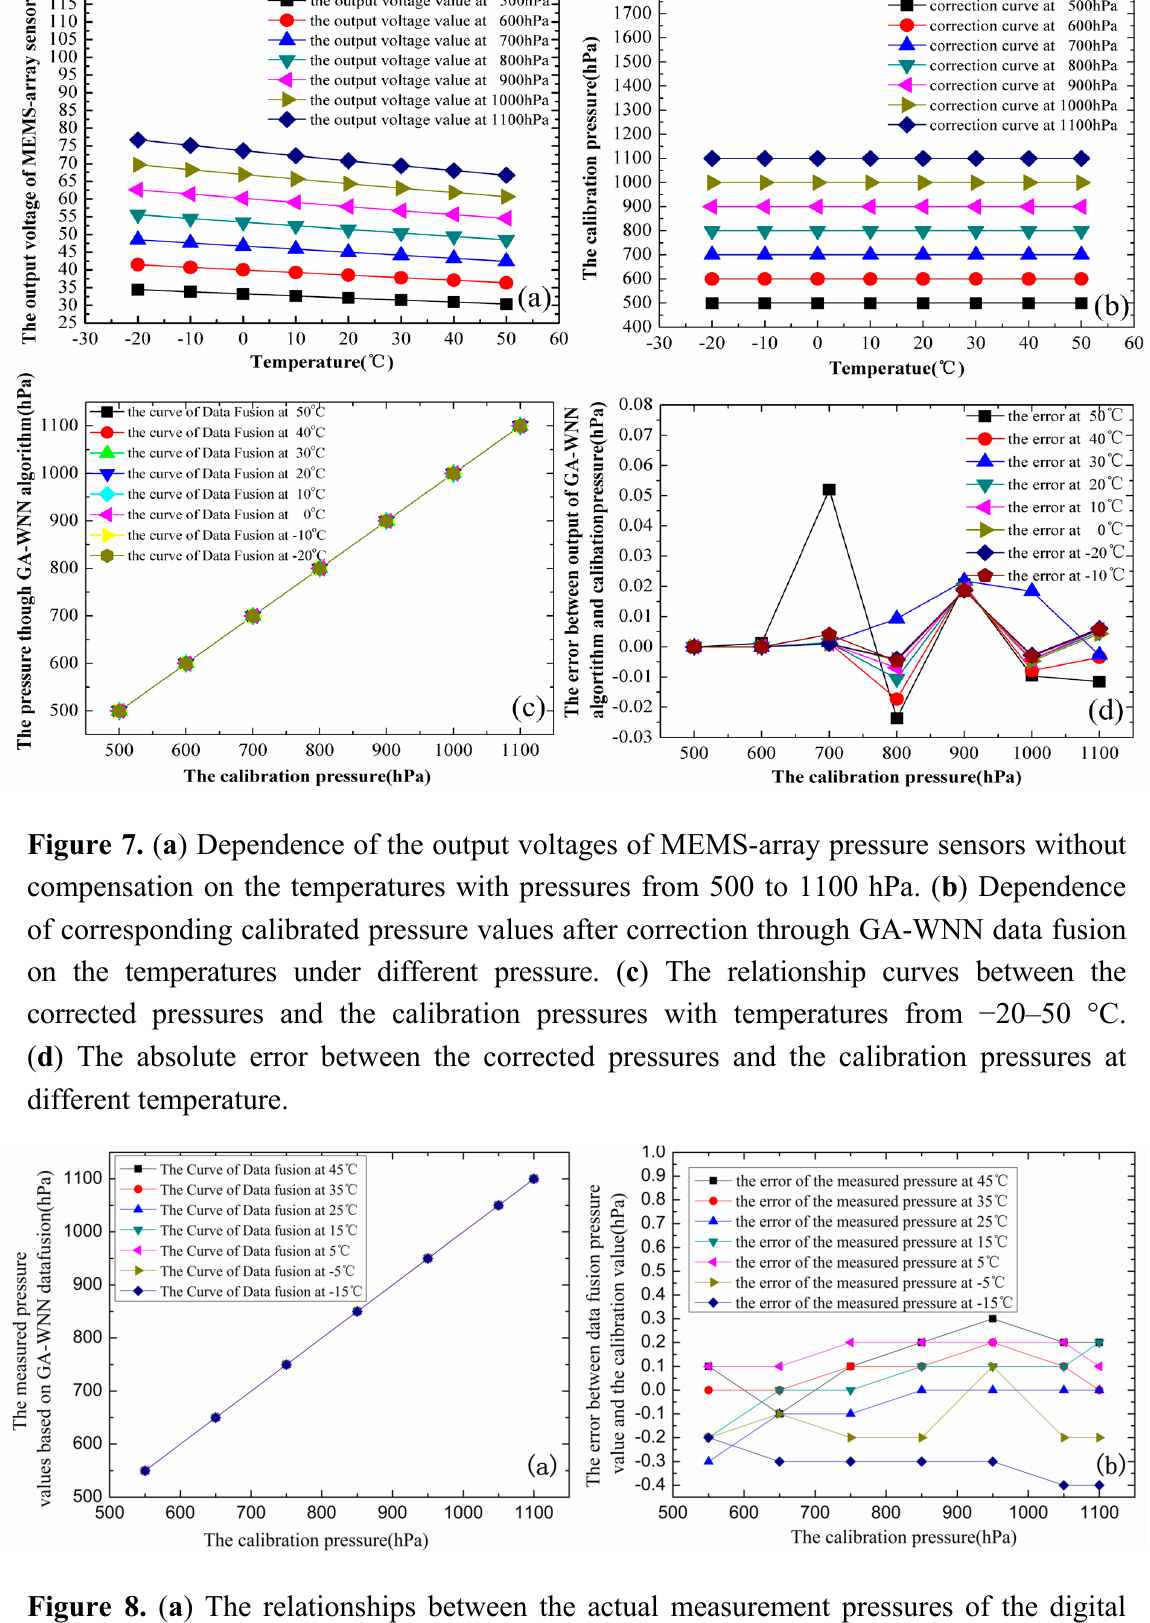
Figure 8. ( a ) The relationships between the actual measurement pressures of the digital MEMS-array pressure transmitter designed in the paper and the calibration pressure of the Fluke pressure generator at different temperature. ( b ) The absolute error between